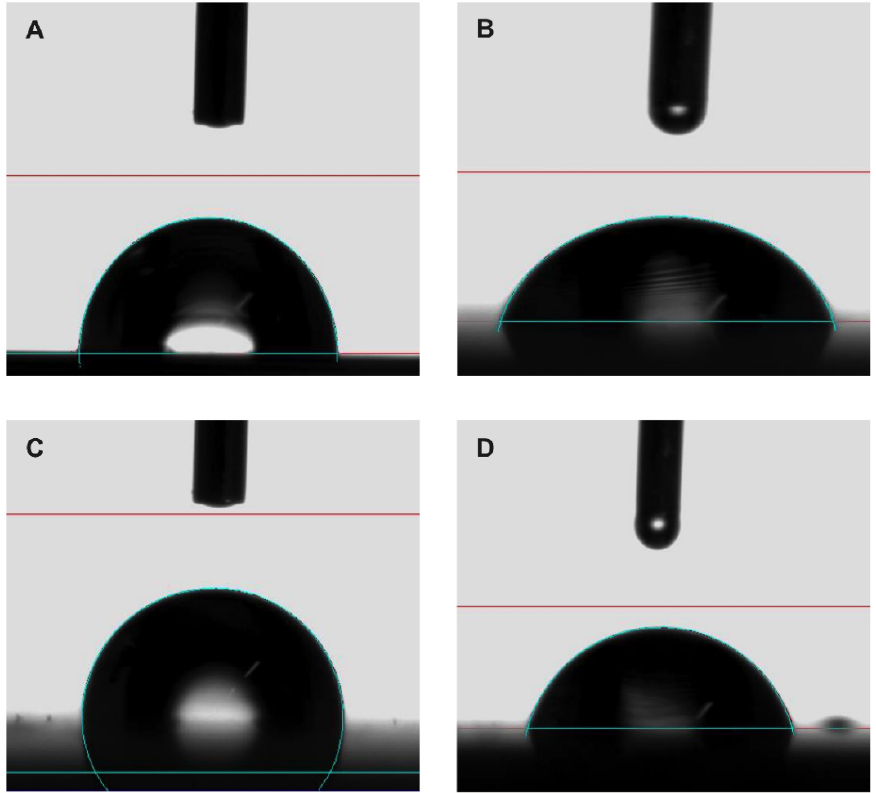
Figure 7. Representative contact angle images of ( A , C ) water and ( B , D ) diiodomethane on uncoated and coated sample, respectively.